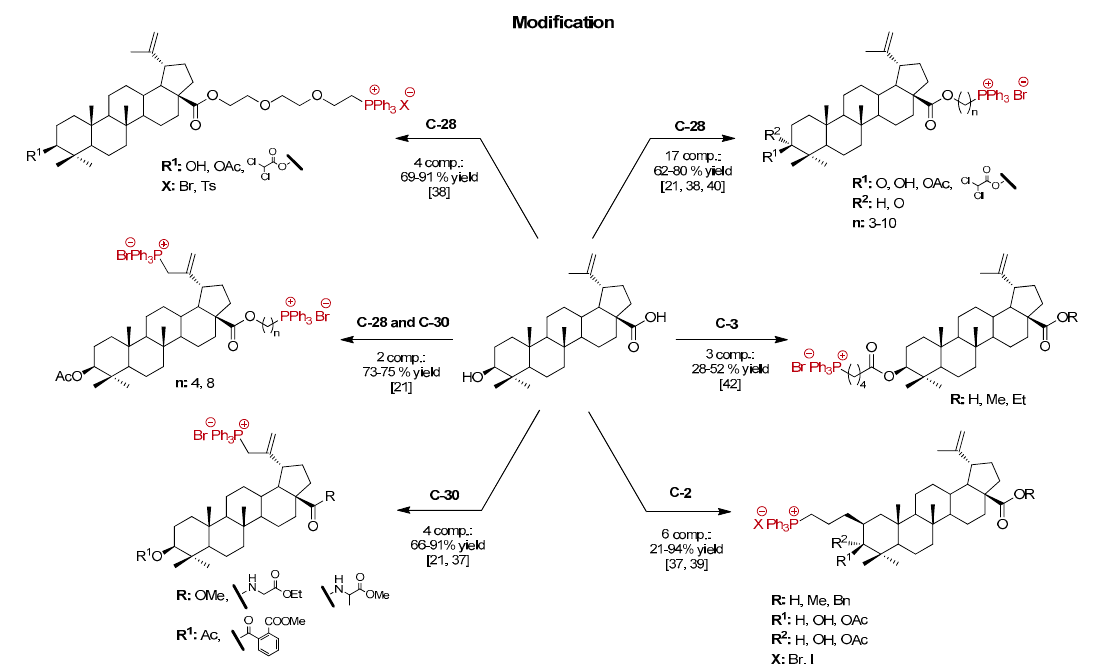
Figure 3. The chemical structures of the TPP ⊕ -conjugated with BA .